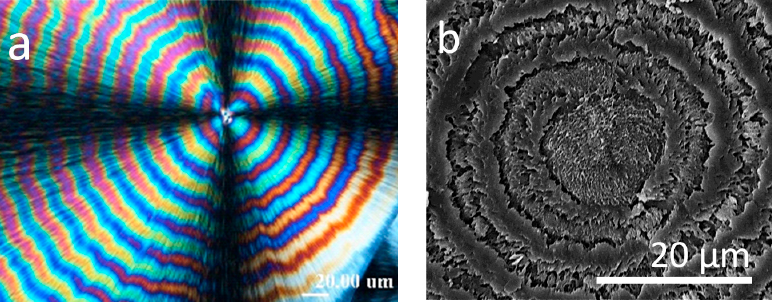
Figure 16. Birefringent rings and crevices between the rings in PTT spherulite crystallized at 165 °C: ( a ) POM graph of virgin PTT; and ( b ) SEM graph of 20 min KMnO 4 -etched PTT. Reproduced from Ref. [47] with permission from The Royal Society of Chemistry.